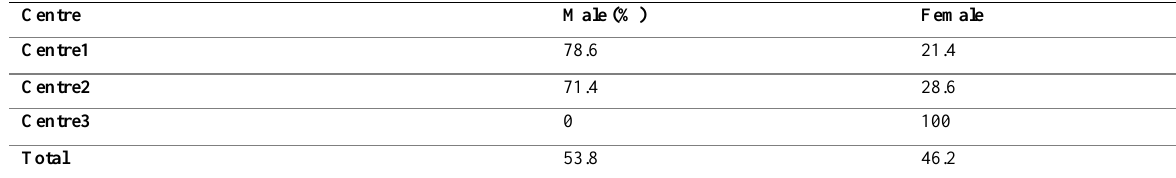
Table 6: Distribution of Children in Each Centre by